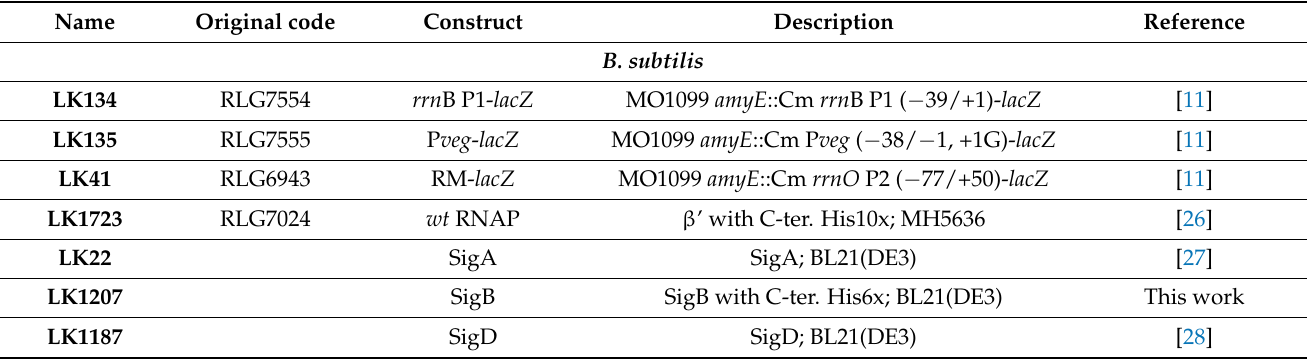
Table 1. Bacterial strains used in a